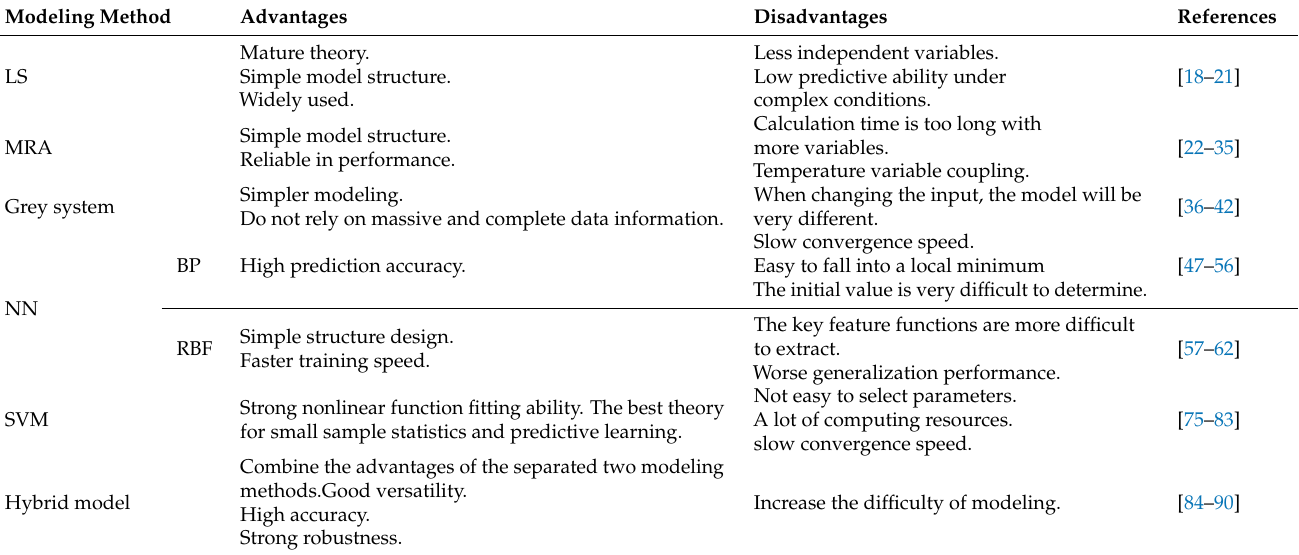
Table 1. Comparison of different thermal error modeling